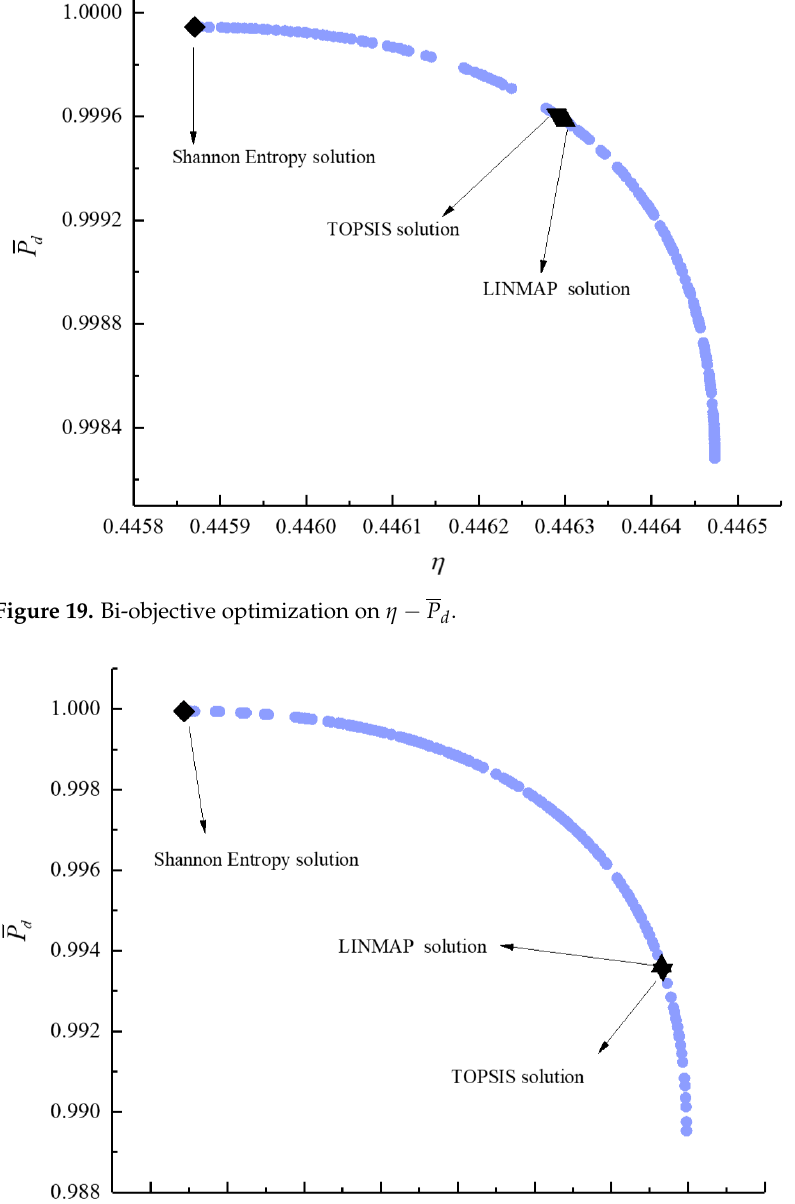
Figure 18. Bi-objective optimization on E − .